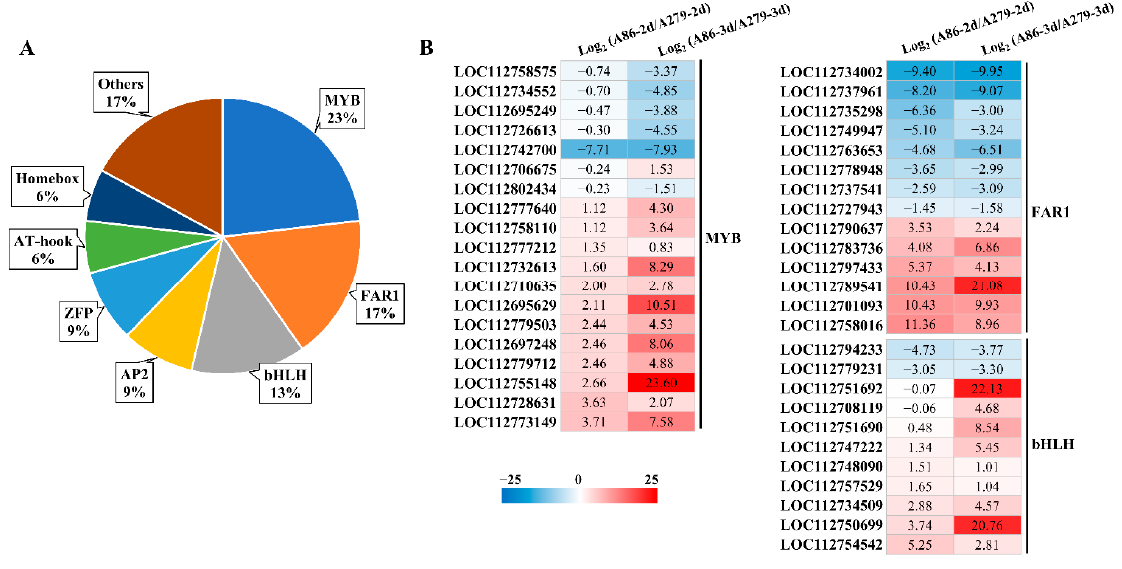
Figure 6. The expression of DEGs involved in transcriptional regulation. ( A ) Pie chart showing the frequency distribution of DEGs involved in transcriptional regulation. ( B ) Heat-map showing the differences in the expression of representative transcription factor families.